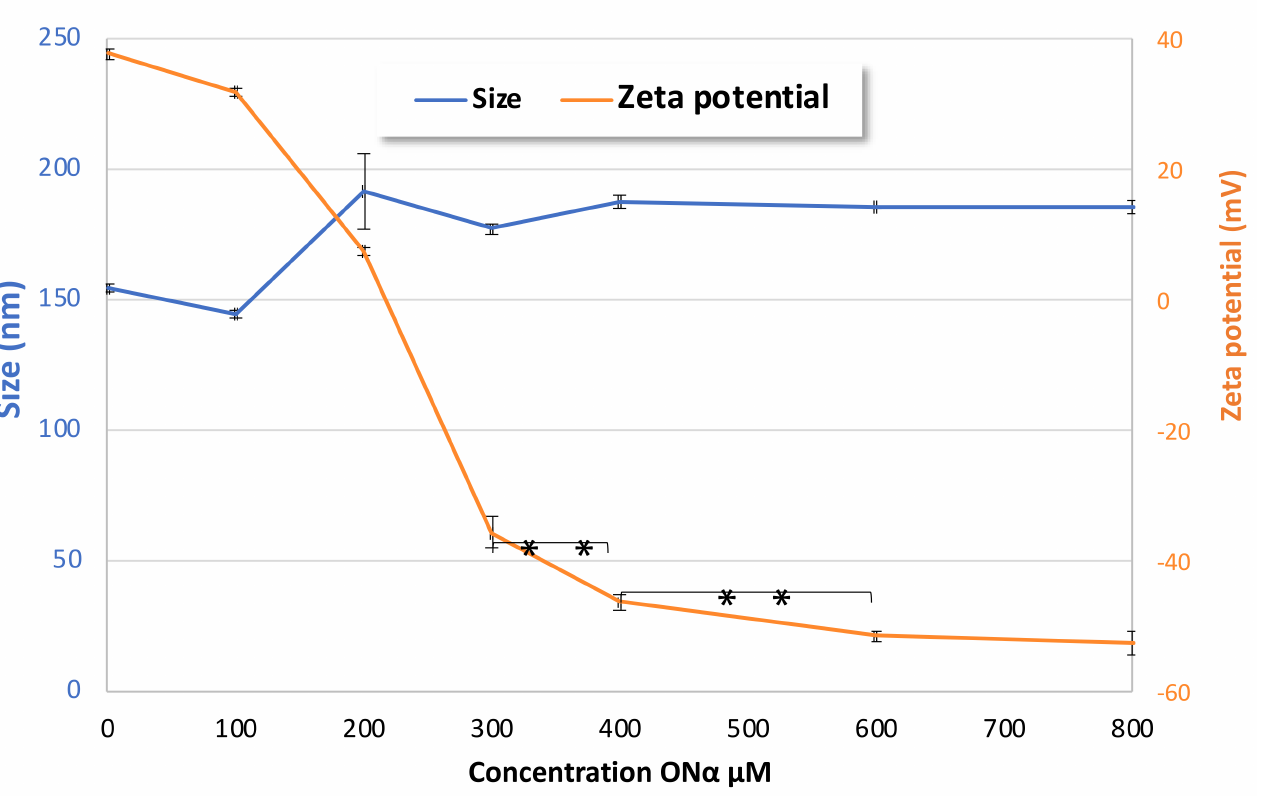
Figure 5. Evolution of the effects of ON α NP size and zeta potential on ON α concentration during formulation (** p < 0.01, Student t